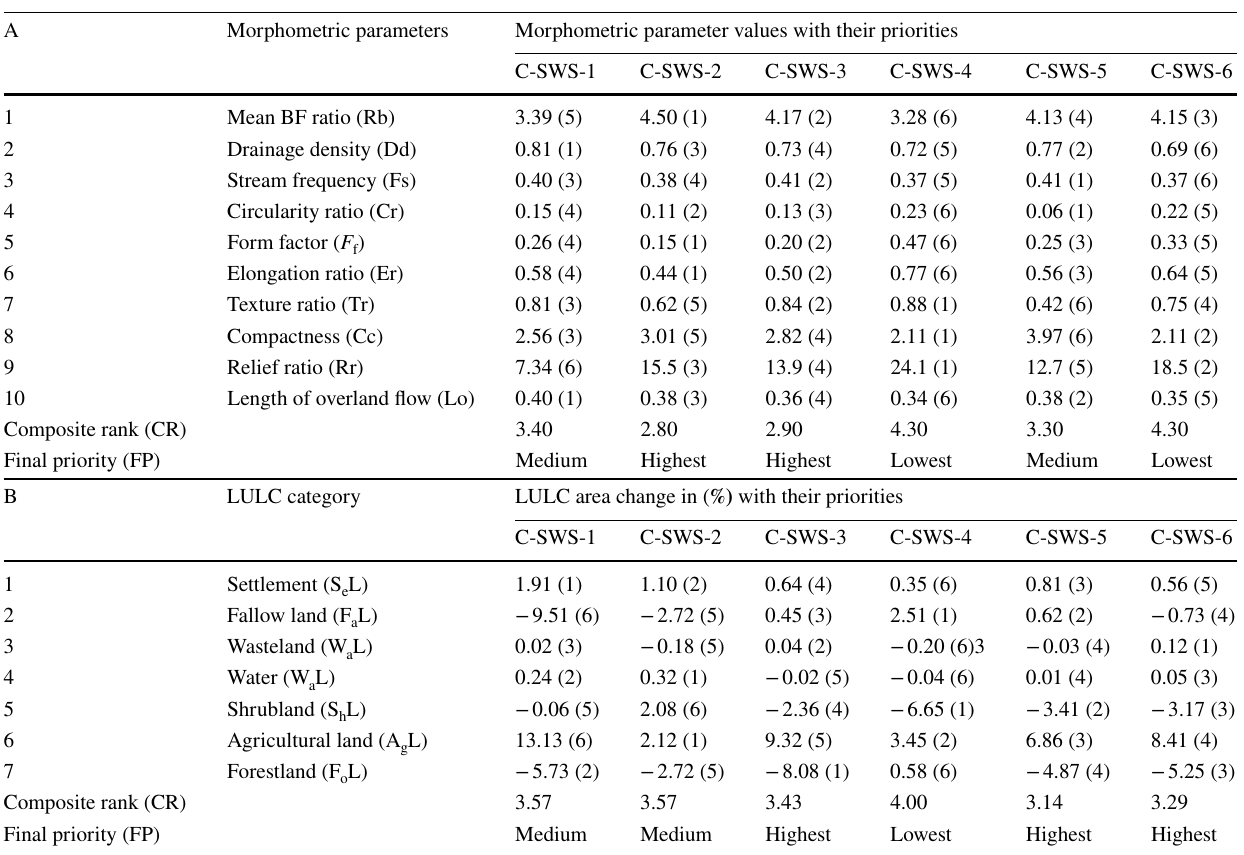
Table 8 Prioritization of sub-watersheds (morphometric parameters and LULC category) A Morphometric